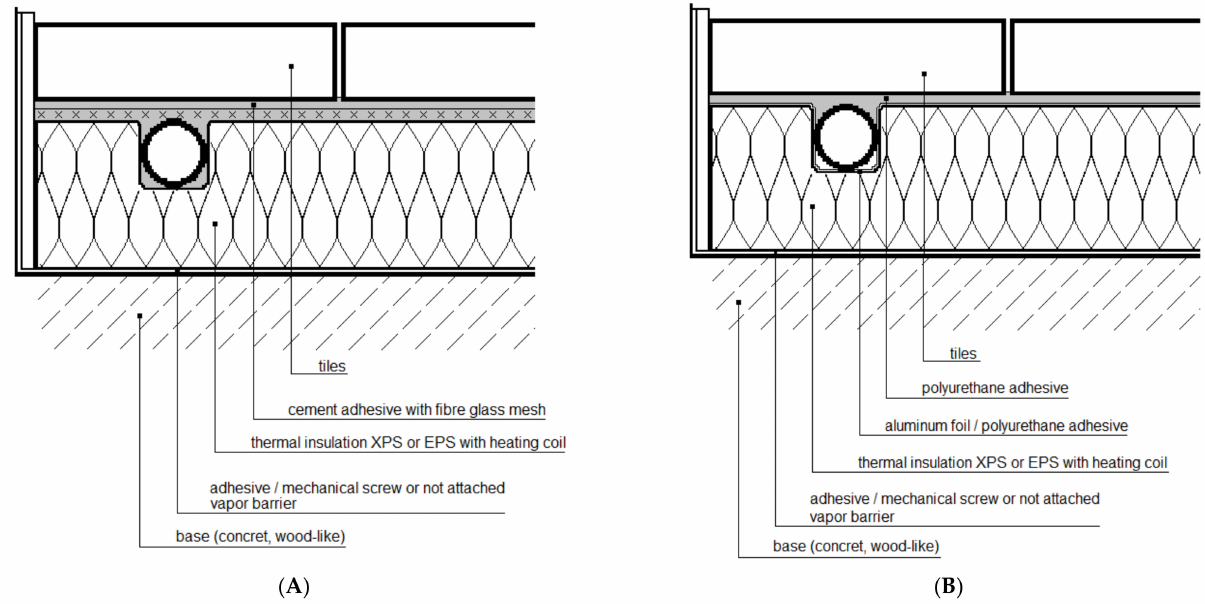
Figure 1. Cross-sections of a lightweight radiant heater ( A ) without a heat-dissipating layer (lamellas), and ( B ) with the heat-dissipating lamellas, namely aluminium